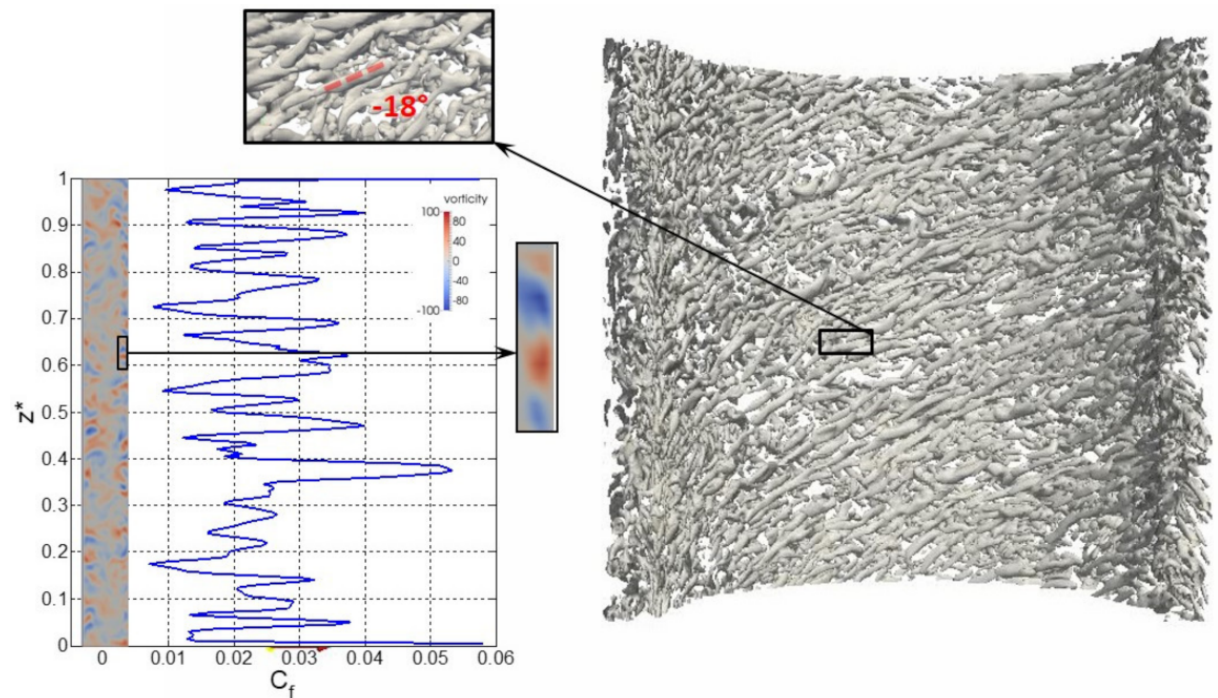
Figure 7. Simulation LES in the near-wall region of a Taylor–Couette–Poseuille flow. Q-criterion applied for angular assessment of the vortex